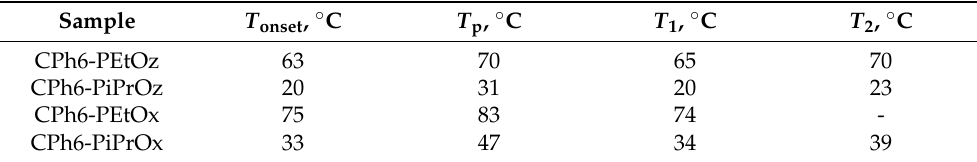
Figure 9. Concentration dependencies of the phase separation temperature T 1 for star-shaped CPh6-PAlOz and CPh6-PAlOx. Table 3. Phase separation temperatures of solutions of star-shaped pseudo-polypeptoids at concentration c = 0.015 g cm –3 .